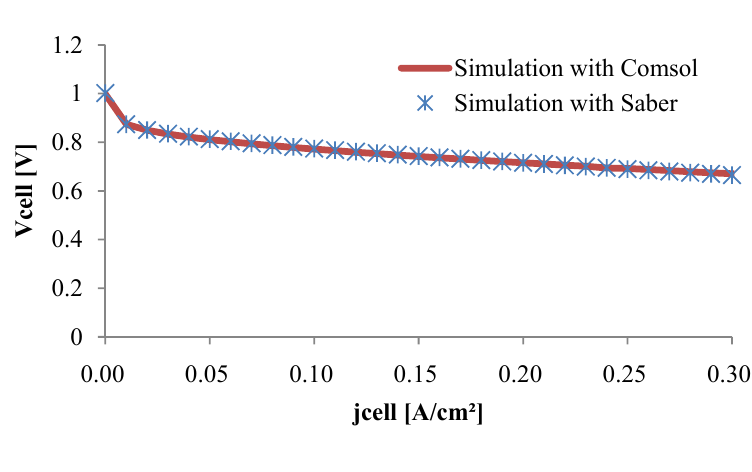
Figure 9. Polarization